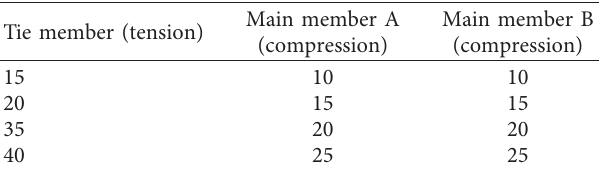
Table 1: Loading condition of a 132-kV composite crossarm under normal conditions.